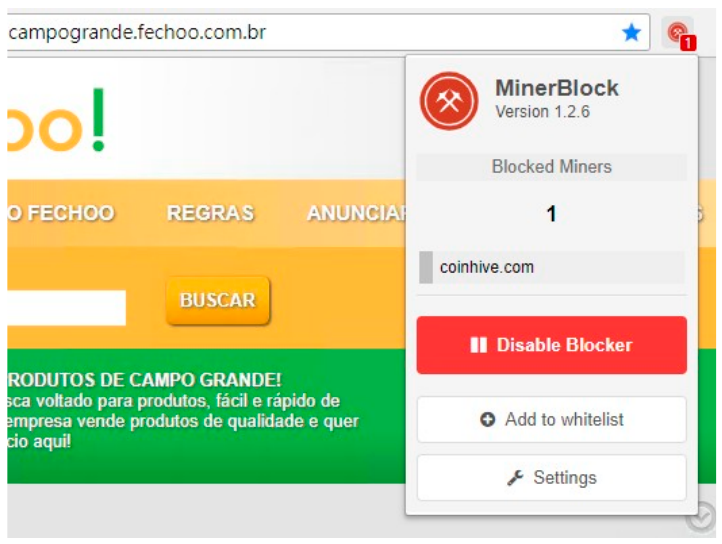
Figure 4. MinerBlock. Figure 4.